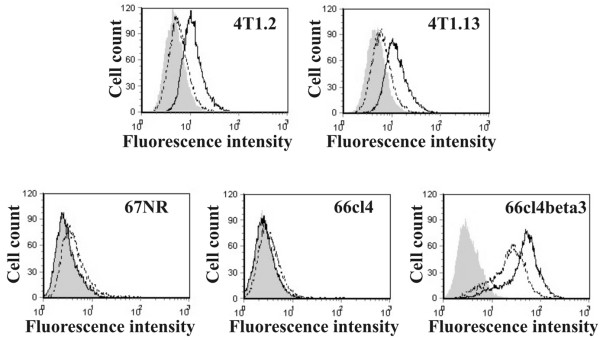
αvβ3 integrin expression in tumor lines of the metastasis model. Cell surface expression of integrin subunits was determined by measuring the specific fluorescence by flow cytometry as described in Materials and methods. Shaded area, isotype; dotted line, αv; solid line, β3.